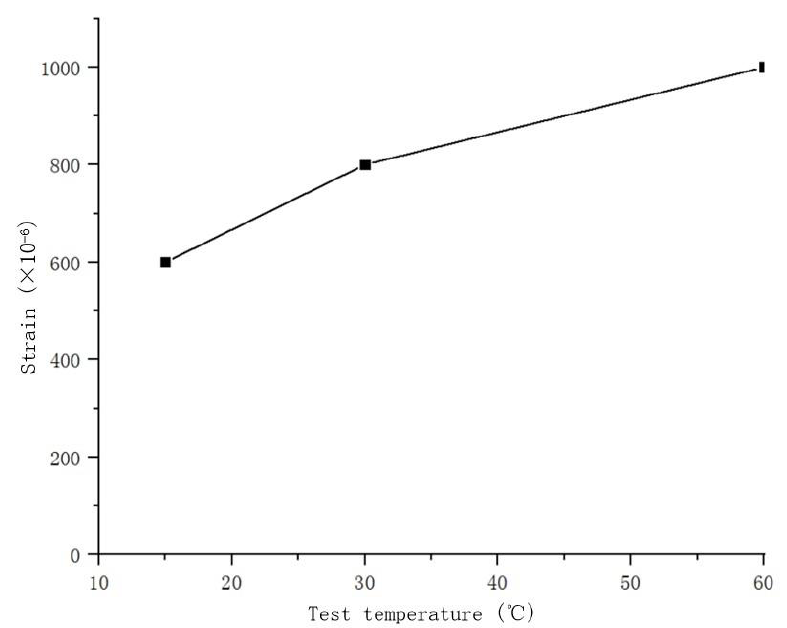
Figure 7. Fatigue endurance ultimate strain level of epoxy asphalt mixture at different test temper-